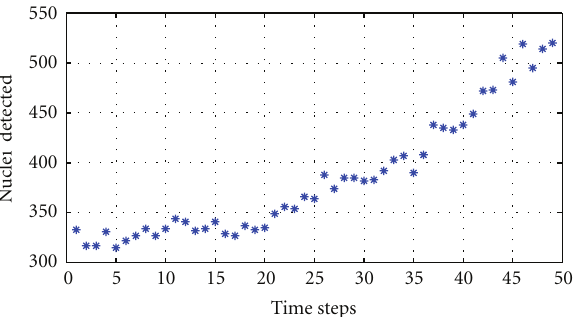
Figure 10: Number of nuclei detected in the whole time lapse